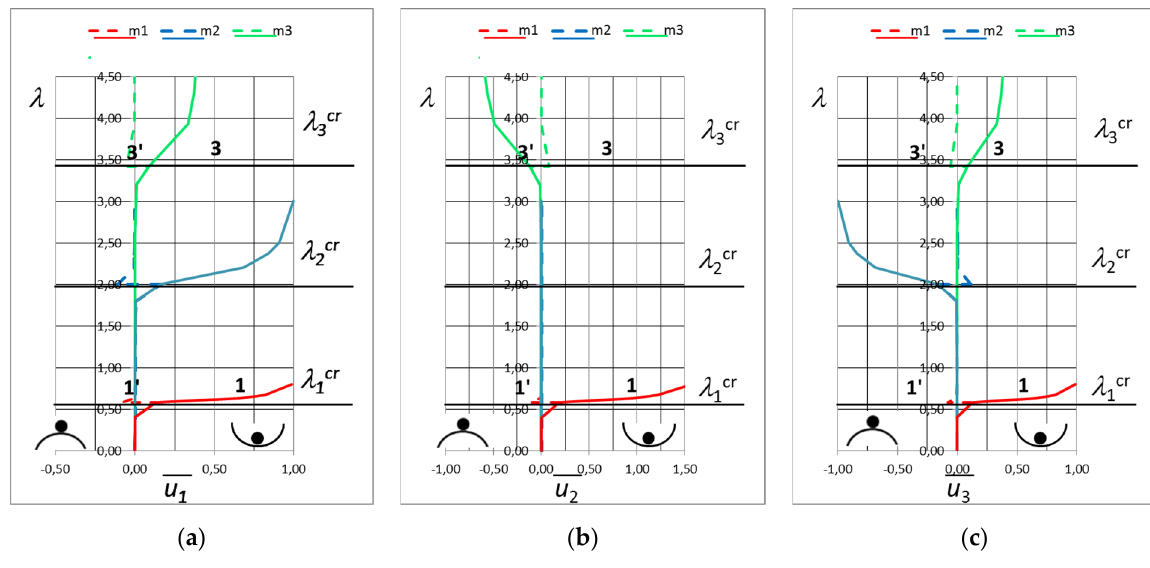
Figure 5. Equilibrium path obtained for small amplitudes of the geometrical imperfections in the shape of the first, second and third buckling mode, respectively ( m 1, m 2, and m 3); displacement of the node: ( a ) No. 1, ( b ) No. 2, ( c ) No. 3.